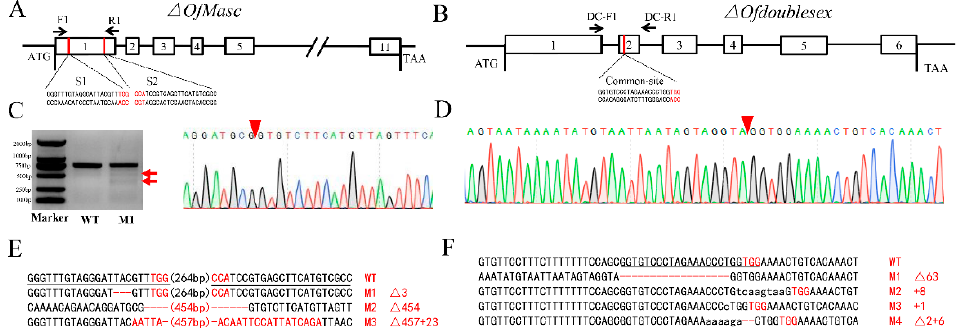
Figure 1. CRISPR/Cas9-mediated mutations in the OfMasc and Ofdsx target sites. ( A ) The two target sites of the OfMasc genome locus focused on the first exon. ( B ) The target site of the Ofdsx genome locus focused on the second exon of the common region in the female and male spliced variants. ( C ) T7 endonuclease I treatment of extracts of wild type (WT) and mutant (M) pupae of OfMasc and genomic sequencing demonstrate alterations at the target site. Arrows indicate the two bands observed in mutants. The red wedge indicates the position of cleavage by the CRISPR/Cas9 genome editing system. ( D ) Sequencing chromatogram of the Ofdsx mutants. The red wedge indicates the position of cleavage by the CRISPR/Cas9 genome editing system. ( E ) OfMasc mutations detected by sequencing. The PAM sequence is in red. The black line represents the target sites. ( F ) Ofdsx mutations detected by sequencing. The PAM sequence is in red. The black line represents the target site.